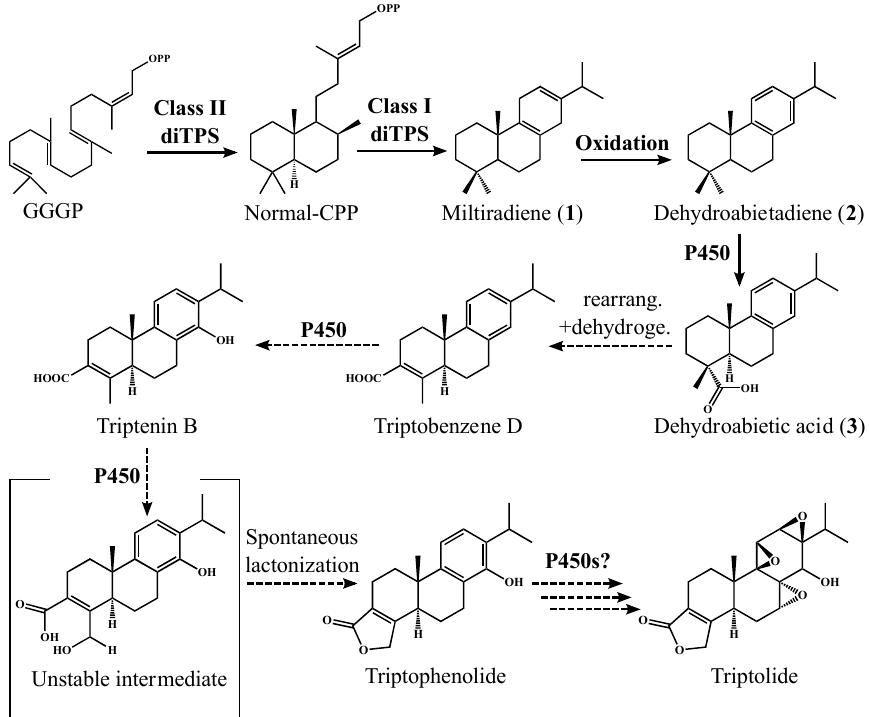
Figure 1. Proposed pathway to triptolide with a key intermediate, dehydroabietic acid. Dehydroabietic acid ( 3 ) is produced from dehydroabietadiene ( 2 ), a product of a pair of diTPS via copalyl diphosphate (normal-CPP) in normal, or (+) stereochemical configuration, to miltiradiene ( 1 ) that can undergo spontaneous aromatization into 2 . 2 is functionalized into 3 by CYP720B4, cytochrome P450. 3 possibly undergoes a carboxylic rearrangement and dehydrogenation to triptobenzene D as a subsequent step. The remaining steps in T. wilfordii towards triptolide could be catalyzed by other P450s. All diterpenoid intermediates in the proposed pathway have been reported in T. wilfordii , with exception of the unstable intermediate that undergoes spontaneous lactonization into triptophenolide.